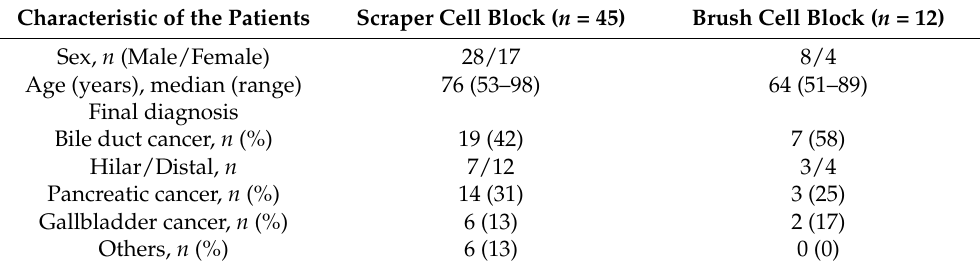
Table 3. Clinical characteristics of the patients diagnosed malignancy by scraper cell block and brush cell block.